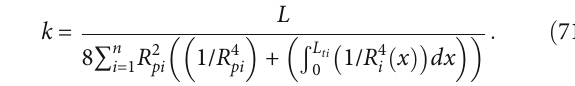
Table 2: Parameters for CO